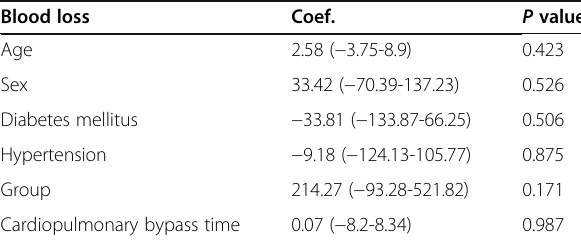
Table 4 Factors affecting postoperative blood loss Blood loss